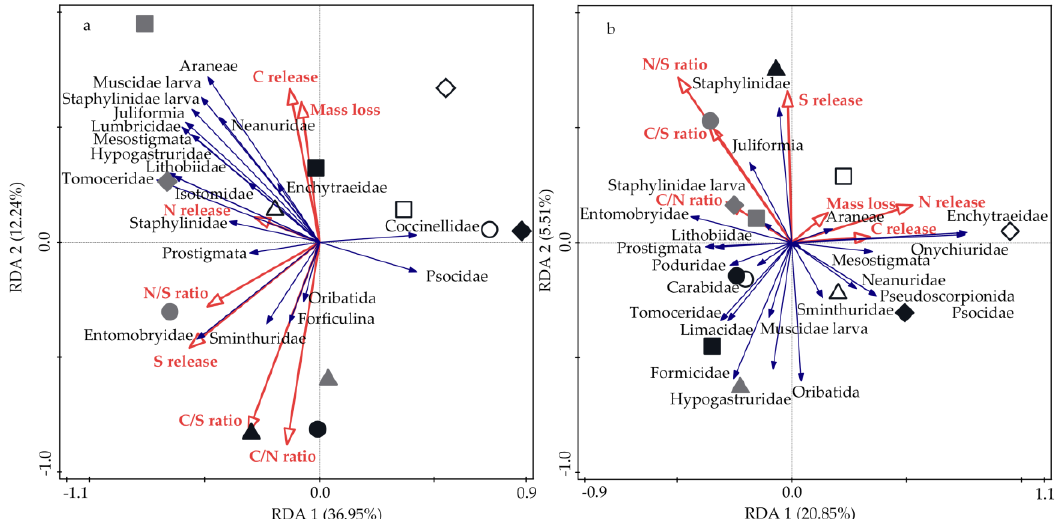
Figure 4. Redundancy analysis (RDA) results of the soil fauna community in association with litter physicochemical properties during the experimental period. Values are the means of different plots within the same experimental period ( n = 3). a: Quercus mongolica forest habitat; b: miscellaneous wood forest habitat. The circle: Q. mongolica (QM); up triangle: Acer pseudosieboldianum (AP); diamond: Juglans mandshurica (JM); square: Ulmus laciniata (UL). Black: after 7 months; Gray: after 9 months; White: after 12 months.